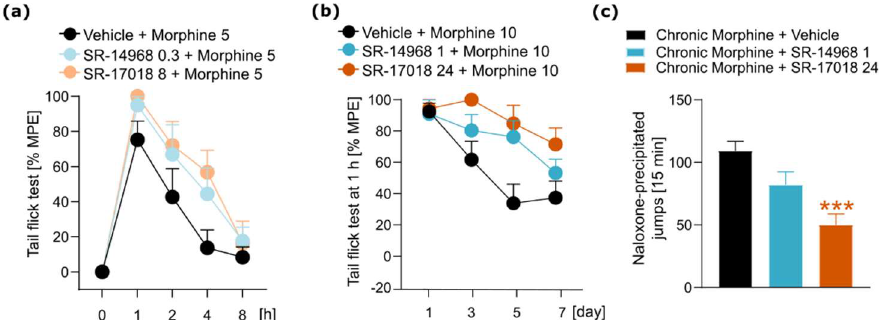
Figure 5. Impact of SR compounds on behavioral effects of morphine. ( a ) Administration of SR-14968 (0.3 mg/kg, i.p.) and SR-17018 (8 mg/kg, i.p.) 30 min prior to morphine (5 mg/kg, i.p.) slightly enhanced morphine-induced antinociception. ( b ) Pretreatment with SR-14968 (1 mg/kg, i.p.) and SR-17018 (24 mg/kg, i.p.) 30 min prior to daily morphine administration (10 mg/kg, i.p.) slightly delayed the development of tolerance to morphine-induced antinociception. ( c ) Pretreatment with SR-14968 (1 mg/kg, i.p.) and SR-17018 (24 mg/kg, i.p.) 30 min prior to naloxone (4 mg/kg, i.p.), resulted in a tendency to (SR-14968)/significant decrease (SR-17018) in the number of withdrawal jumps. Data are presented as the mean ± SEM. Significant effects resulting from post hoc analysis are marked with * (comparison to a group cotreated with morphine and vehicle). *** p < 0.001. Numbers of animals: ( a , c ) all groups n = 9, ( b ) all groups n = 10.